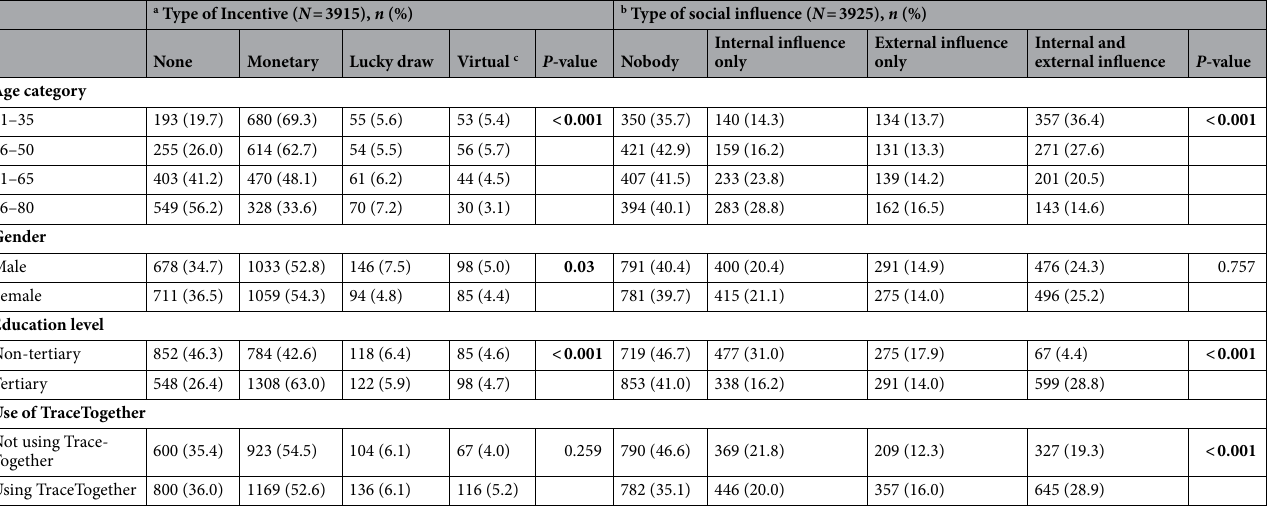
Table 2. Incentives and social influence on the uptake of a Digital Contact Tracing (DCT) tool. Significant values are in [bold]. a Respondents were asked to choose the type of incentive that can motivate people to use a DCT tool. b Respondents were asked to choose from a list of people who could persuade them to use a DCT tool. Internal influence refers to spouse, family members and relatives while external influence refers to friends, colleagues, religious leaders. c Virtual incentives refer to incentives such as virtual badges, motivational messages on respondents’ “good deeds”, and encouragement on reaching certain milestones on app